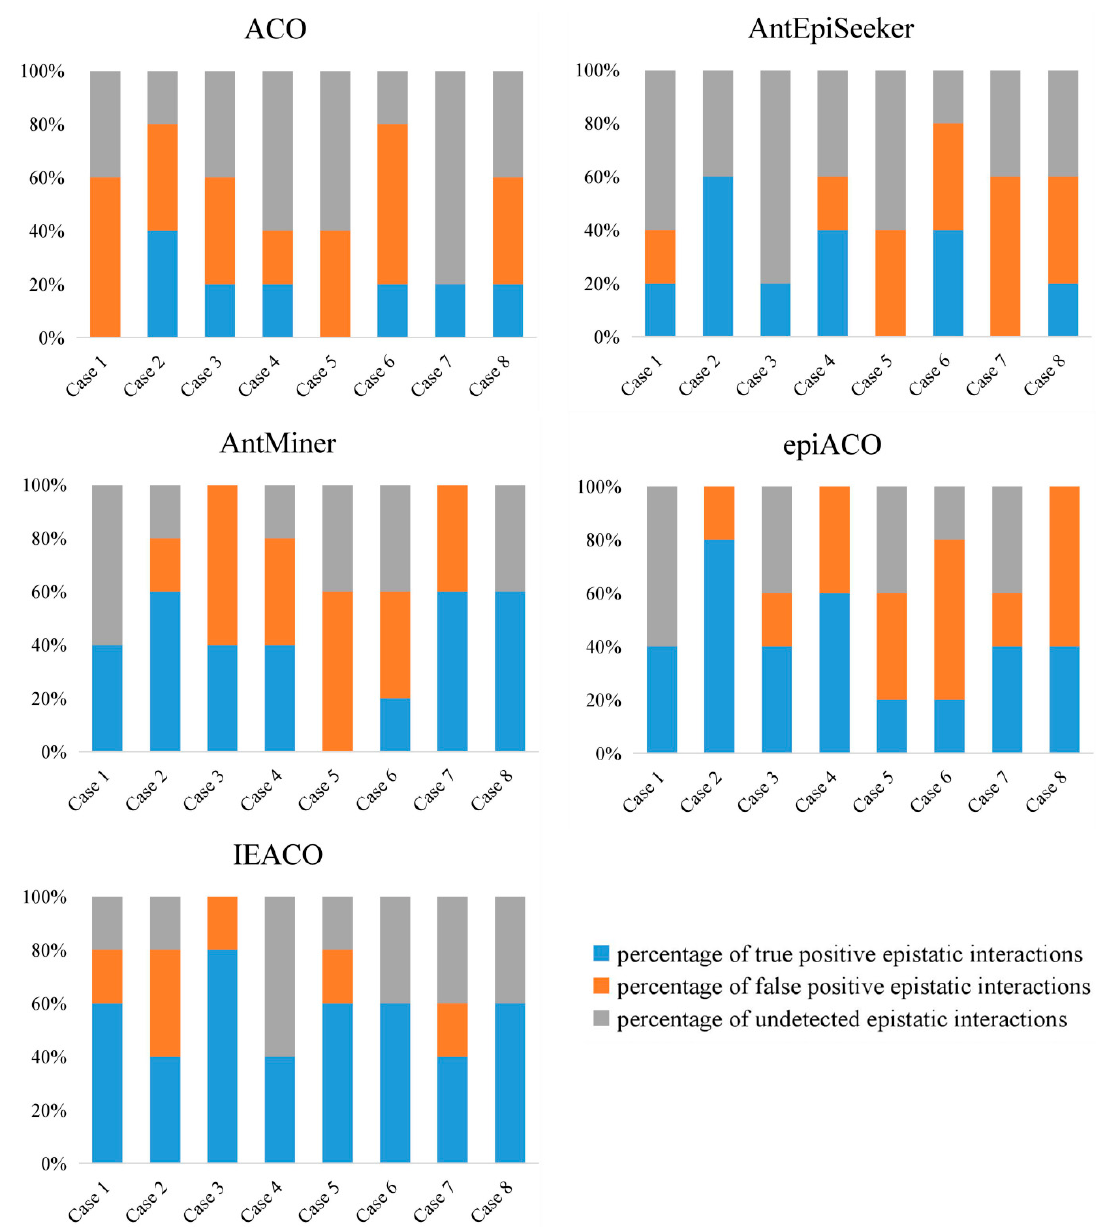
Figure 5. Performance comparison of multiple epistasis detection.